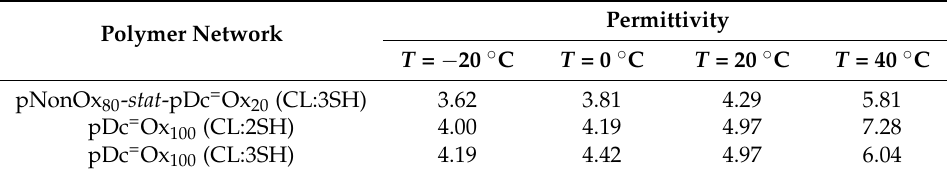
Table 3. Permittivity of the poly(2-oxazoline)-based networks at 50